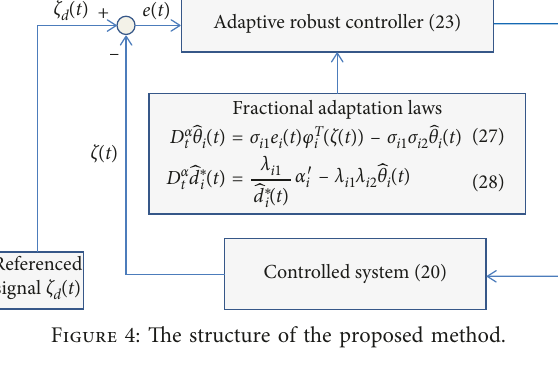
Figure 4: The structure of the proposed